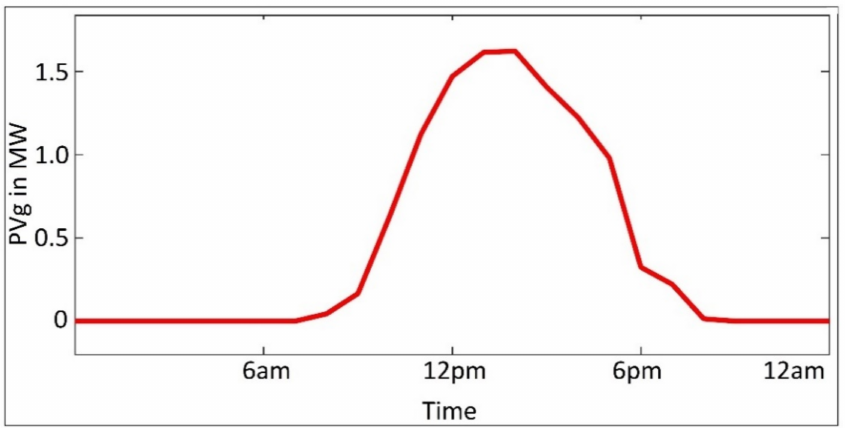
Figure 5. PV generation (average